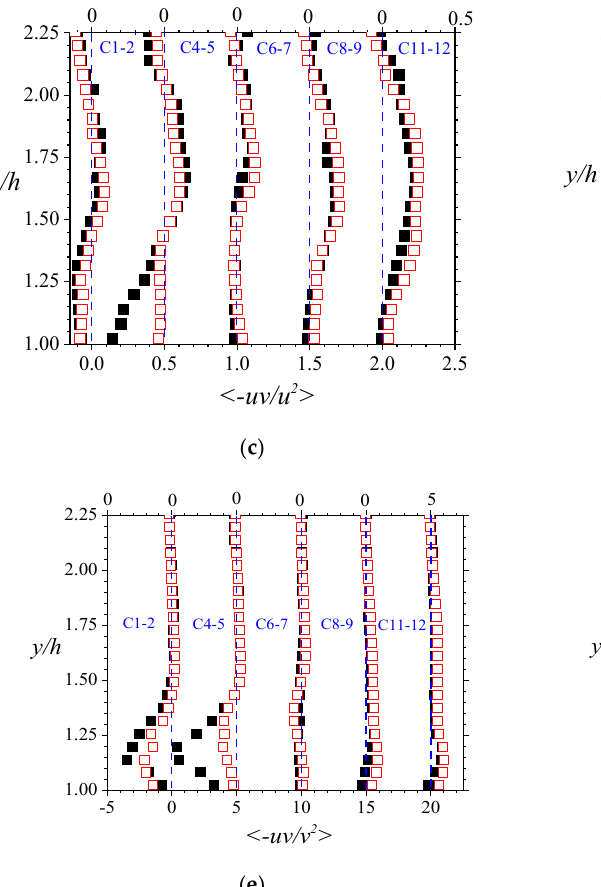
Figure 17. Reynolds stress ratios for the flow in the open region are shown. Staggered plots ( a , c , e ) show the streamwise variations whereas ( b , d , f ) demonstrate the spanwise variations. The denominations C and R respectively stand for columns and rows, and are illustrated in Figure 1. Black-filled boxes are the results for Test A , and red-open boxes are the results for Test B .